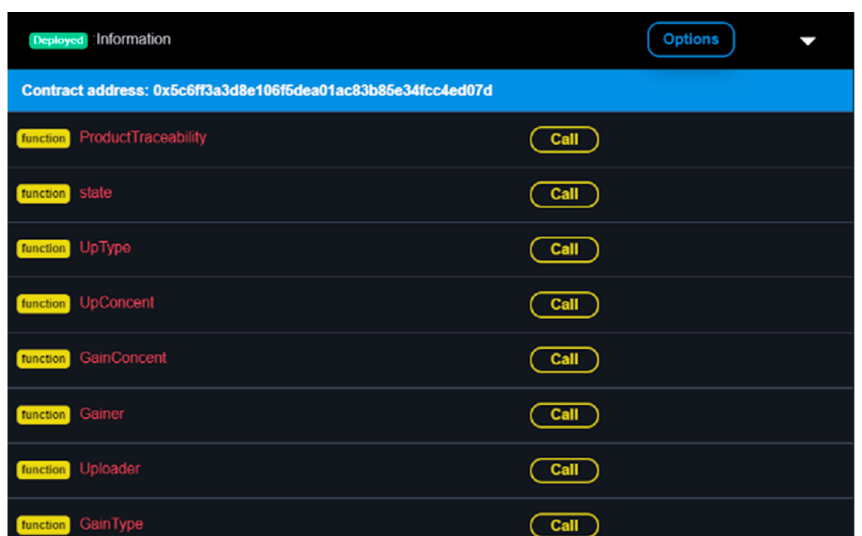
Figure 9. Info smart contract deployment results.